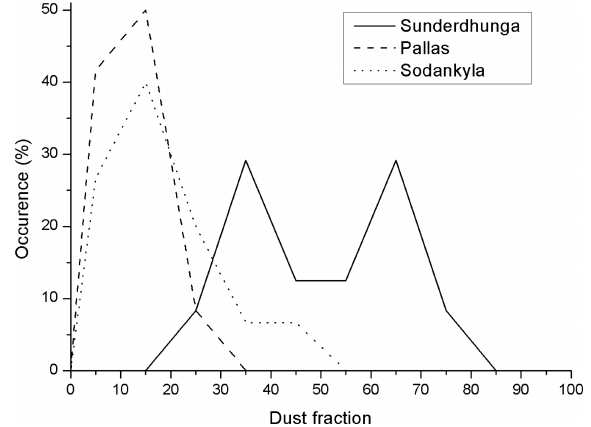
Figure 9. Frequency of the occurrence of dust optical thickness fractions at the three sampling